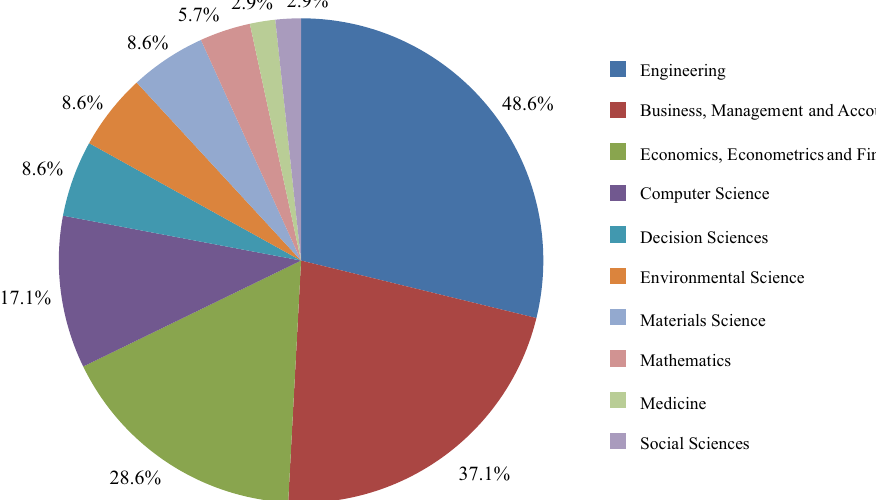
Fig. 3. The classification of published papers using COPRAS-G according to document types